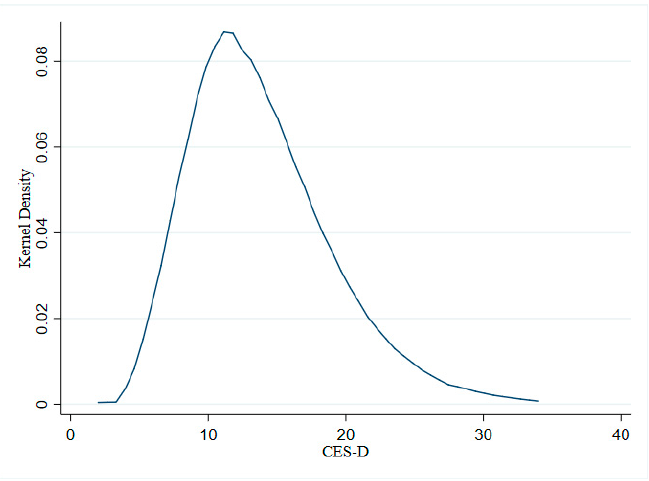
Figure 1. Kernel density curve of CES-D .